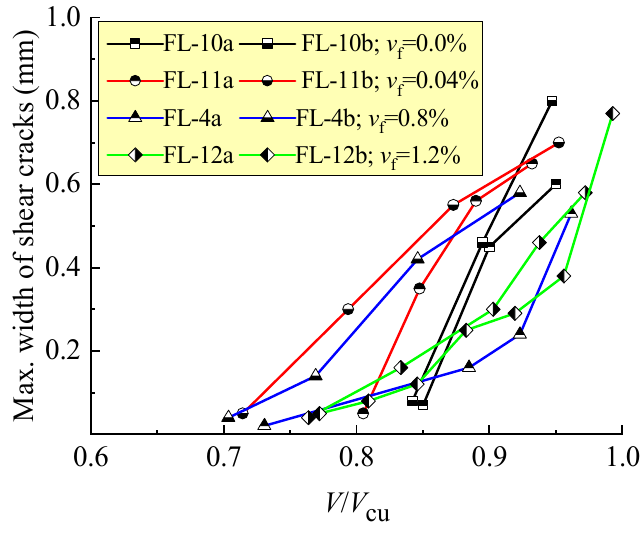
Figure 3. Maximum width of the shear crack on test beams with different v f .